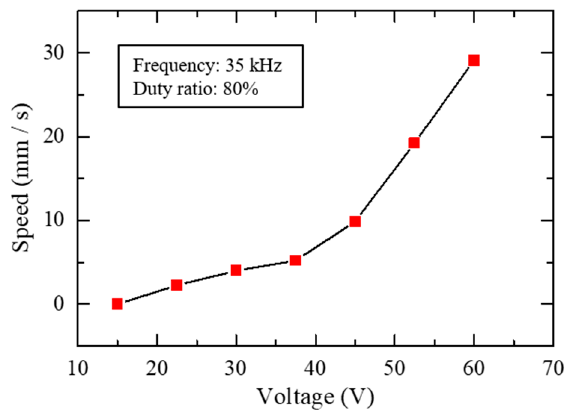
Figure 11. Driving characteristics of the slider 1 at different voltages.